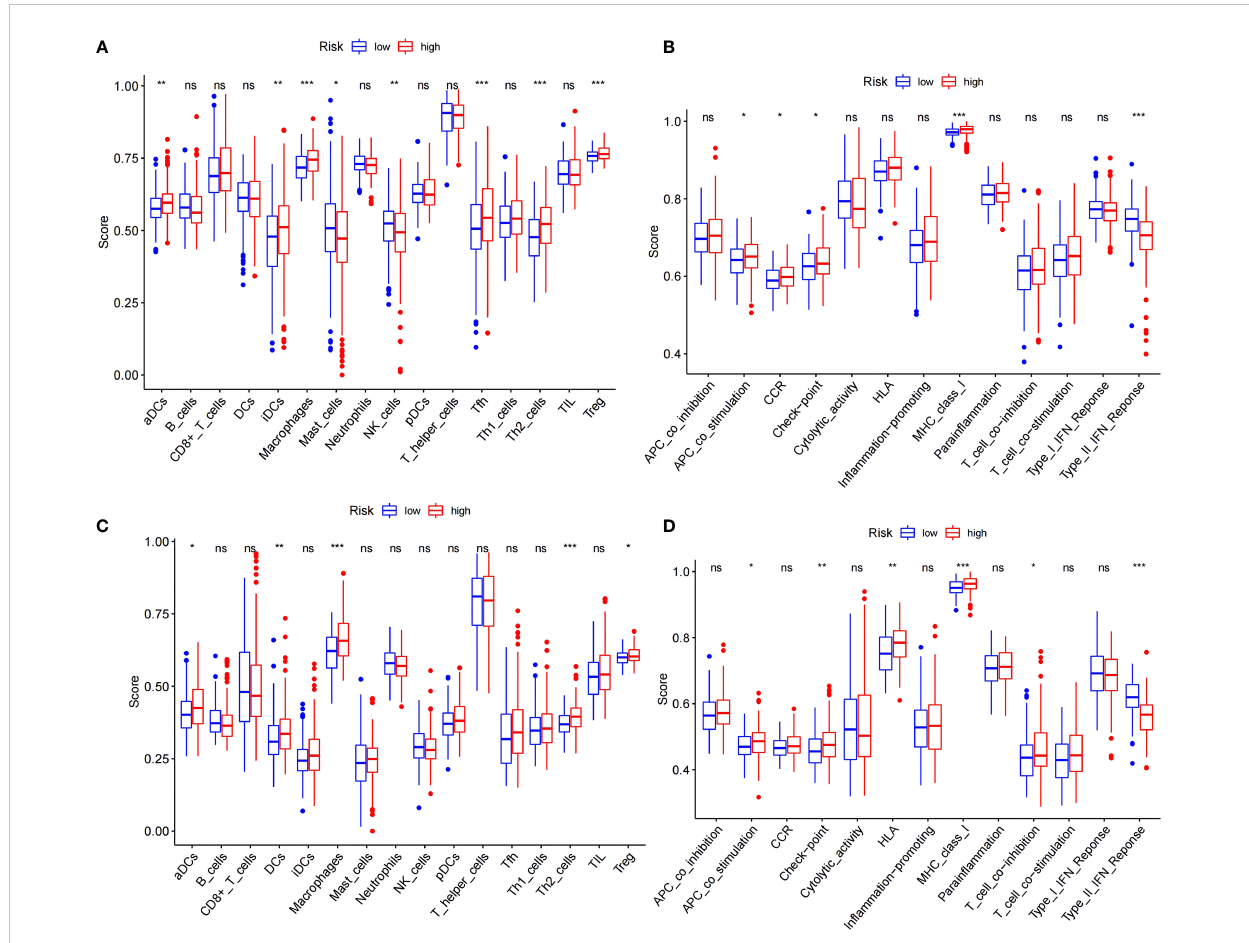
FIGURE 5 Comparison of the ssGSEA scores for immune cells and immune pathways. (A, B) Comparison of the enrichment scores of 16 types of immune cells and 13 immune-related pathways between the low- (blue box) and high-risk (red box) groups in the TCGA cohort. (C, D) Comparison of tumor immunity between the low- (blue box) and high-risk (red box) groups in the ICGC cohort. * p < 0.05; ** p < 0.01; *** p < 0.001. ns: No signi fi cant